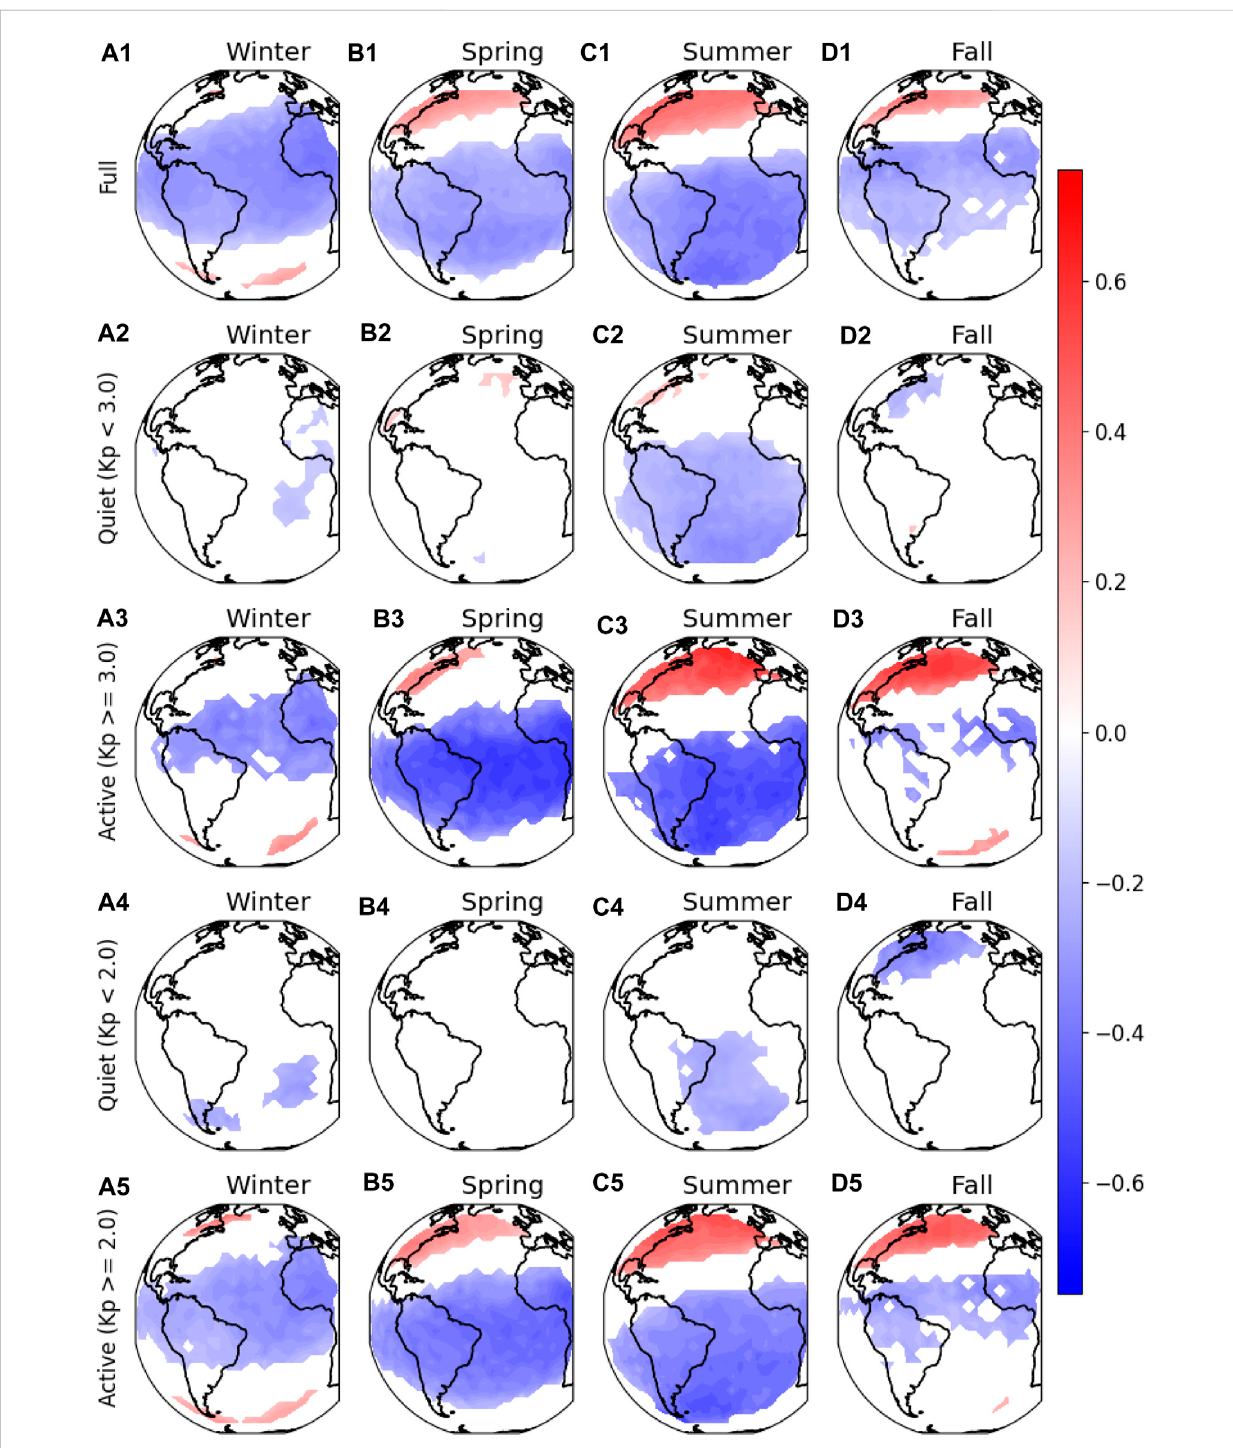
FIGURE 5 (A1 – D1) Correlation maps between O/N 2 residuals and Dst indices for the four seasons. Data gaps are present where the signi fi cance level is less than 95%. (A2 – D2) and (A3 – D3) are the same except only for quiet time (with Kp < 3.0) and active (Kp ≥ 3.0) times. (A4 – D4) and (A5 – D5) are the same except for quiet time with Kp < 2.0 and Kp ≥ 2.0